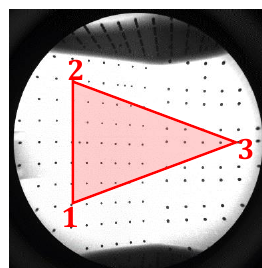
Figure 10. Distribution of selected three targets for